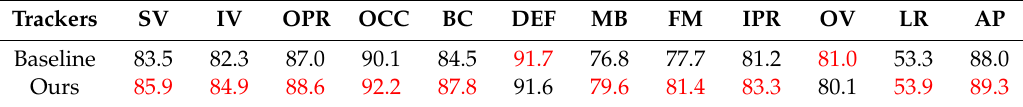
Table 1. Central position accuracy and average accuracy of the proposed tracker and baseline tracker in 11 di ff erent attributes. Red represent the better performance.